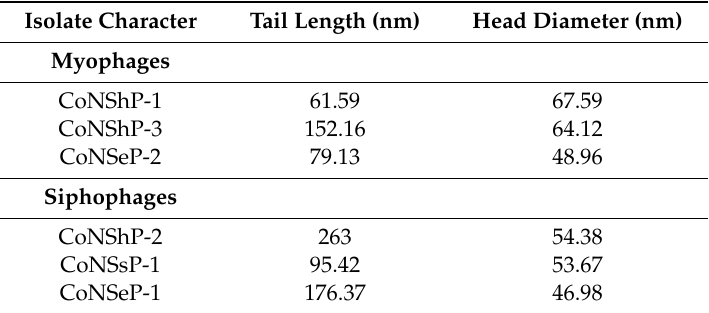
Table 3. Morphotypes and dimensions of the CoNS isolated phages.